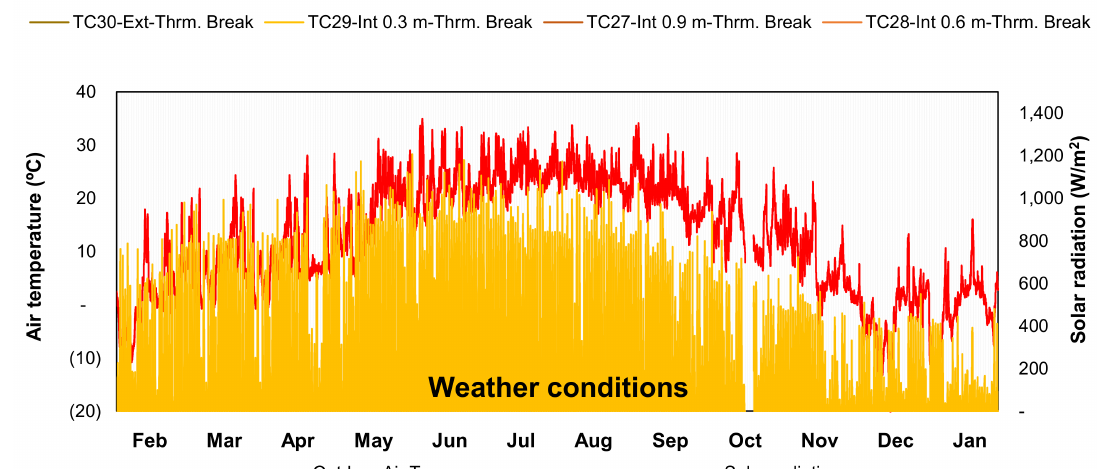
Figure A5. Experimental data for balcony pair